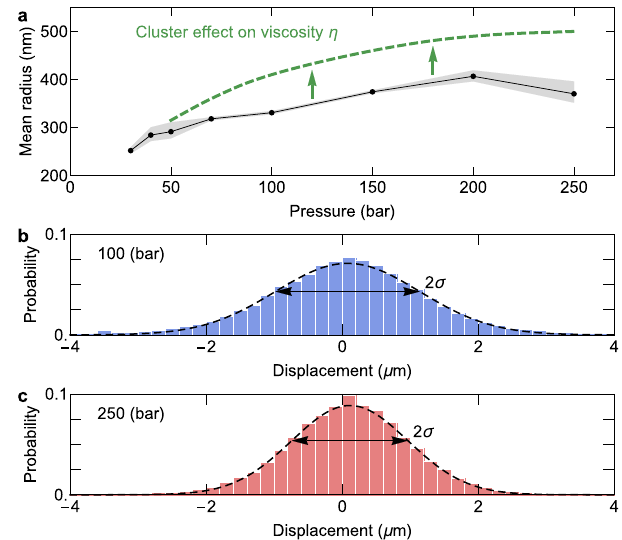
Fig. 5 Mean size of droplets at different pressures. a Brownian motion analysis is adopted to measure the mean size at each pressure. The droplet motions are split into two axes, which gives two sets of one-dimensional displacements. The medium viscosity tends to decrease with the appearance of the clusters. The green dashed line depicts the change in estimated droplet sizes, taking into account the cluster effect on the viscosity in a situation where the cluster density is high as in our experiments. The error band shows 90% con fi dence interval of normal distribution fi t for each pressure. b , c . The histograms show the displacement of droplets during the elapsed time (0.02 s) and their normal distribution fi ts at 100 bar and 250 bar, respectively.